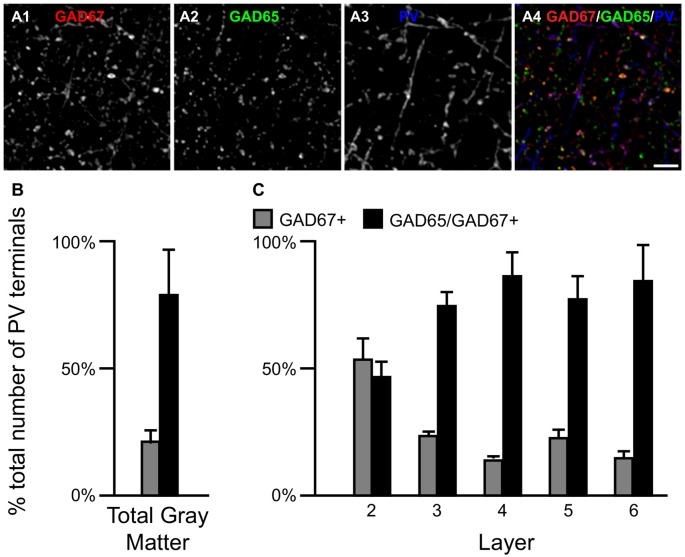
The proportion of two PV/GAD+ terminal subpopulations differs across cortical layers. (A) Projection image (5 z-planes separated by 0.25 μm) of a human PFC tissue section immunolabeled for PV, vGAT (not shown), GAD65 and GAD67. Gray scale images (A1–A3) are single channel images of the multichannel image (A4) and are representative of the immunohistochemistry labeling. Scale bar = 5 μm. (B,C) Bar graphs showing the relative proportions of vGAT/PV+ terminals in PFC that were GAD67+ or GAD65/GAD67+. Error bars = SEM.